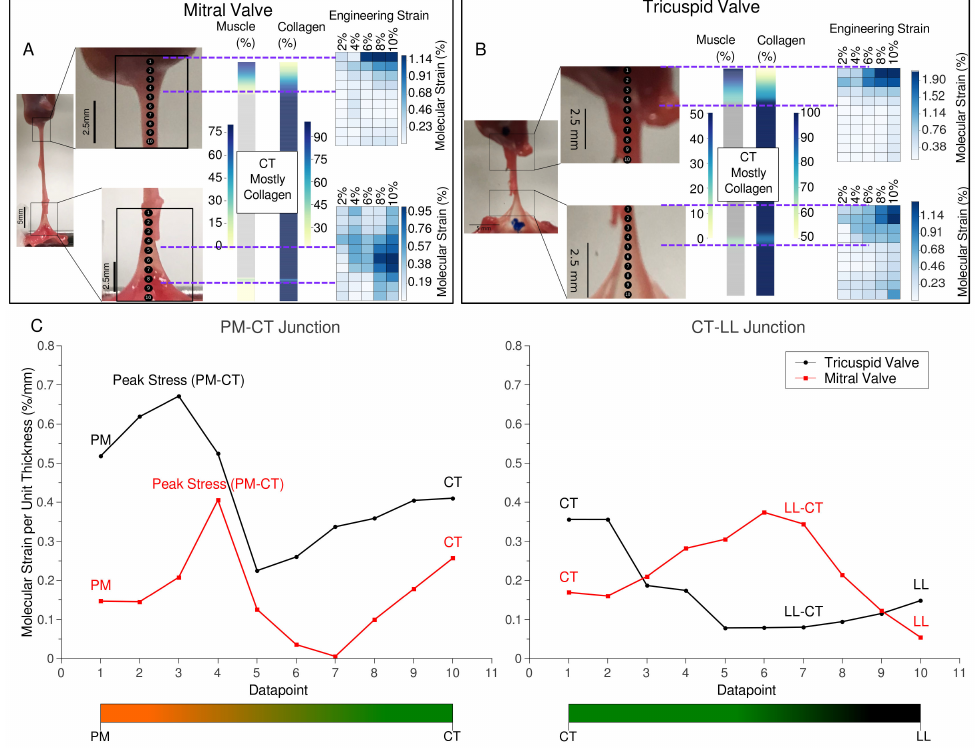
Figure 2. Tissue composition and molecular strain vs. applied engineering strain maps from ‘bisected’ MV and TV samples. ( A , B ) Composition maps showing muscle and collagen percentages along